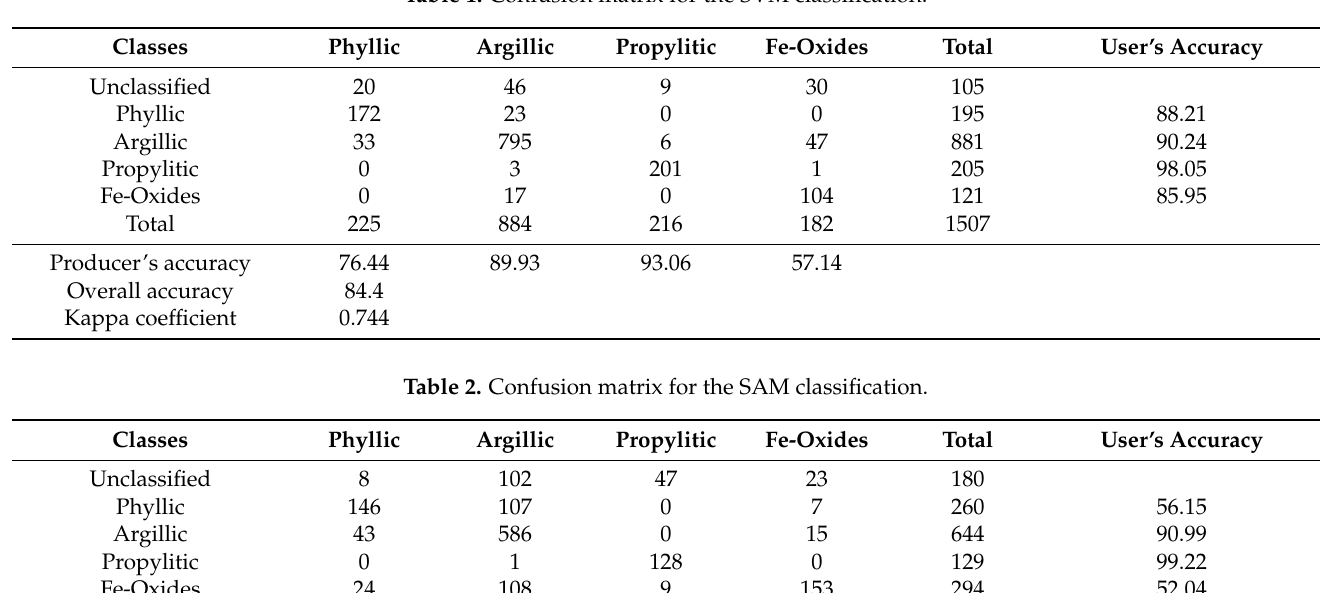
Table 1. Confusion matrix for the SVM classification.